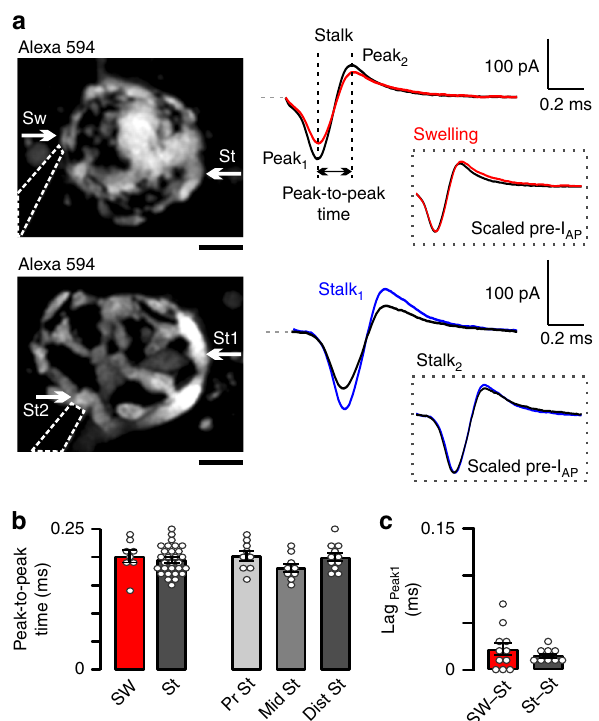
Fig. 2 Action potential waveforms are similar throughout the calyx. a Calyces are visualized in z -axis projection images (Alexa 594, 60 μ M; dashed lines: cell-attached pipette). White arrows indicate the sites of presynaptic compound action potential current (pre-I AP ) recordings (Sw swelling, St stalk). Stimulation artifacts were removed (dashed lines show baselines). Peak-to-peak time is the interval between peak 1 and peak 2 of pre-I AP (vertical lines and black arrow). Inset: amplitude scaled pre-I AP -s in swellings and stalks. b – c Bar graphs summarize peak-to-peak times in swellings and stalks (Sw, 0.201 ± 0.011 ms, n = 8/7, St, 0.195 ± 0.005 ms, n = 29/15, t = 0.612, p = 0.545, df = 35, unpaired t -test) or at different distances from heminode in stalk (Pr St, proximal stalk, 0.202 ± 0.009 ms, n = 9/9, Mid St middle stalk, 0.181 ± 0.008 ms, n = 9/5, Dist St distal stalk, 0.200 ± 0.007 ms, n = 11/7, p = 0.141, F 2,26 = 2.12, one-way ordinary ANOVA). Lags are calculated as delay between peak 1 -s at different locations (stalk to swelling, 0.0218 ± 0.0067 ms, n = 11/7, stalk to stalk, 0.0156± 0.0024 ms, n = 9/8; t = 0.877, p = 0.398, df = 12, unpaired t -test with Welch correction). Bar graphs summarize mean ± SEM. Scale